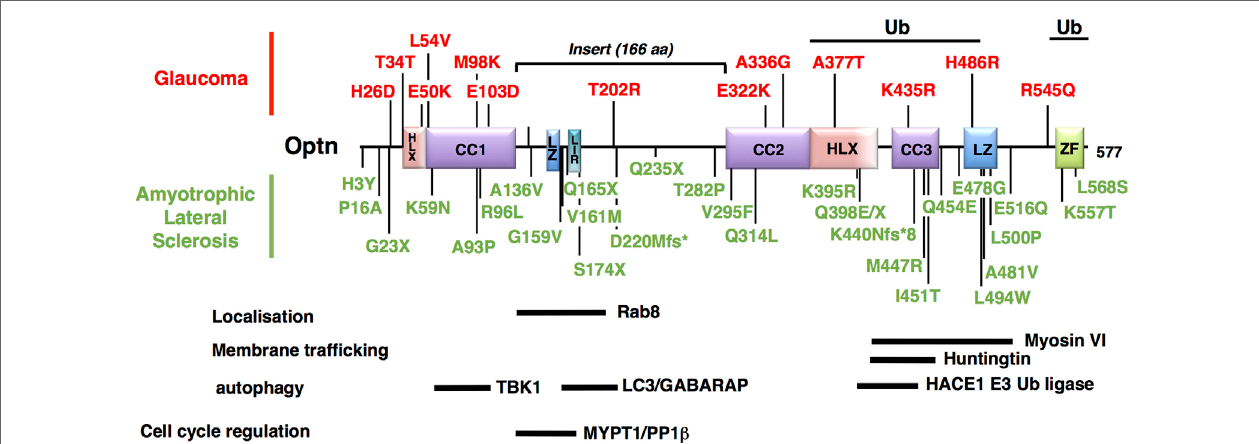
FigURe 4 | Mapping of the neurodegenerative disease-associated mutations of Optineurin (Optn). Localization of the disease-associated polymorphisms and mutations of human Optn protein is shown (as described in Table 1 ). Mutations associated with POAG and juvenile open-angle glaucoma are indicated in red, while mutations linked to amyotrophic lateral sclerosis are in green. Optn contains multiple protein interaction domains that are important for its localization and its mitophagy-related function. The regions of human Optn that have been involved in the interaction with its different partners are represented as thick bars with their